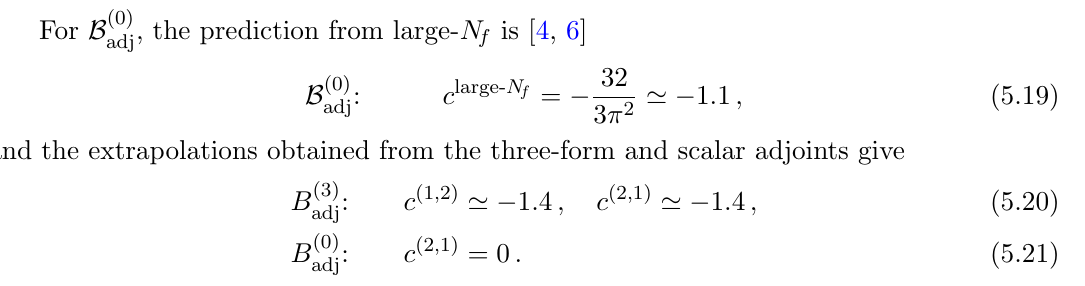
Figure 5 . (cid:15) -expansion predictions for the scaling dimension of the scalar bilinear operators B (0) (left panel), and B (0) (right panel) at d = 3. The di(cid:11)erent colors for B (0) adj from di(cid:11)erent continuations of the operator (see